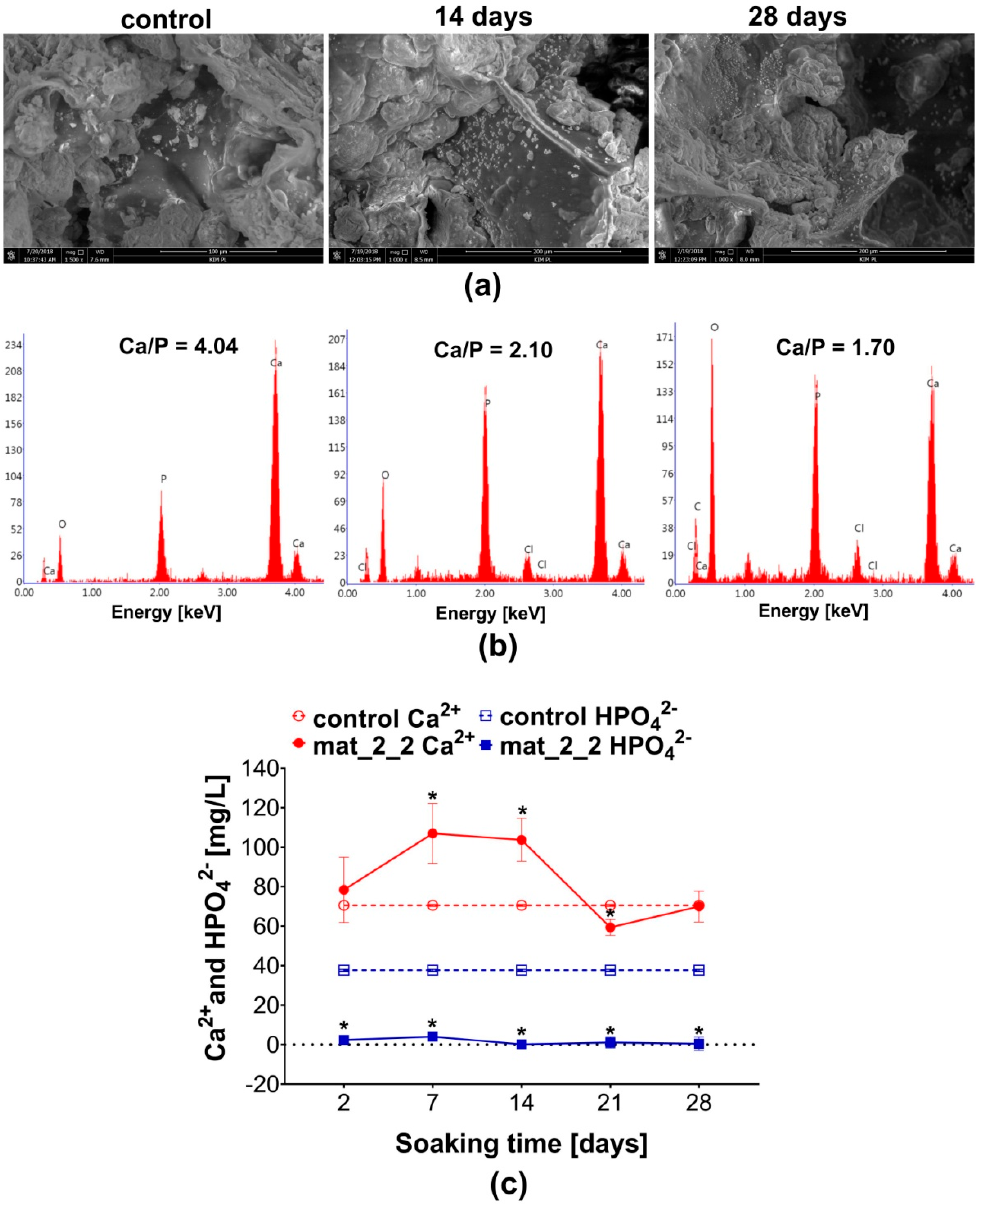
Figure 3. Bioactivity test: ( a ) SEM visualization of the surface of the mat_2_2 before its immersion in simulated body fluid (SBF) (control sample; magnification 1500×, scale bar = 100 µm) and after incubation in the SBF for 14 and 28 days (magnification 1000×, scale bar = 200 µm); ( b ) EDS spectra of apatite precipitates on the surface of the mat_2_2 along with calculated Ca/P atomic ratio; ( c ) Ca 2+ and HPO 42 − concentrations in the SBF samples collected during incubation with the mat_2_2 (control Ca 2+ and control HPO 42 − ion concentration in the fresh SBF; *statistically significant results compared to the control SBF, p < 0.05, unpaired t-test).